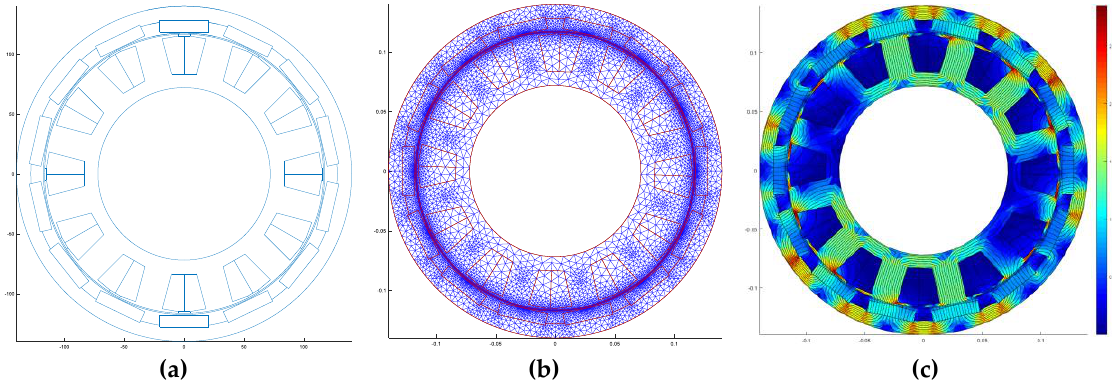
Figure 9. An example view of ERPMSM with 12 concentrated coils and 14 magnets: ( a ) view of ERPMSM construction; ( b ) FEM triangle grid for motor calculations; and ( c ) magnetic field strength map B (𝑇) in the motor at a stator current of 150 A RMS.